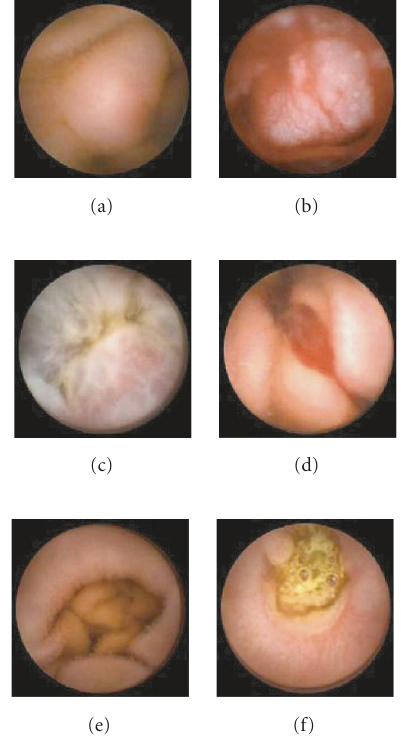
Figure 15: Six typical digestive tract images with 256 ∗ 256 size.